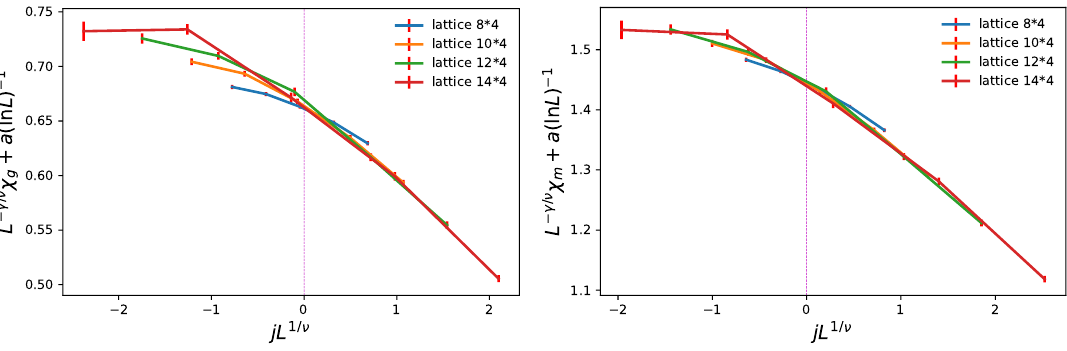
Figure 8 . Finite size scaling analysis of the gauge field (lhs. plot) and matter (rhs.) susceptibilities. coupling of J = 0 . 65 and compare four different volumes L 4 with L = 8 , 10 , 12 and 14 . The results are again plotted as a function of ln(2 πβ ) . Note that the order parameters are not symmetrized under S , such that here we do not expect symmetry under β ↔ ˜ β . The top row of plots show that both expectation values h| T thermodynamic limit. In the bottom plots we show L 2 h| T This rescaling collapses the data and establishes that the volume scaling is ∝ 1 /L 2 = 1 / including also the small remnant of the first order transition at ln(2 πβ ) = 0 , i.e., at the self dual point β = 1 / 2 π